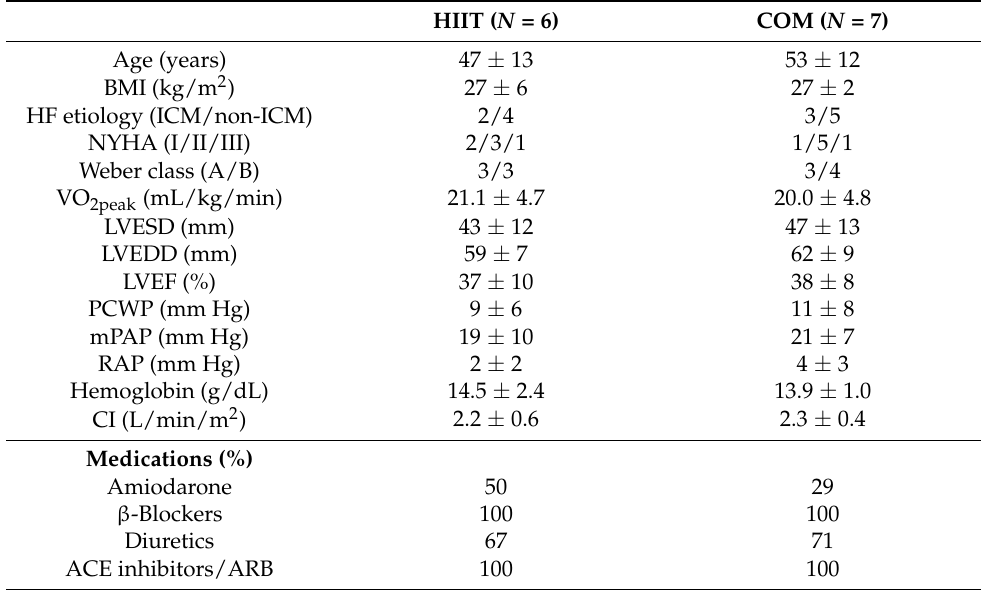
Table 1. Patients’ baseline characteristics and medications